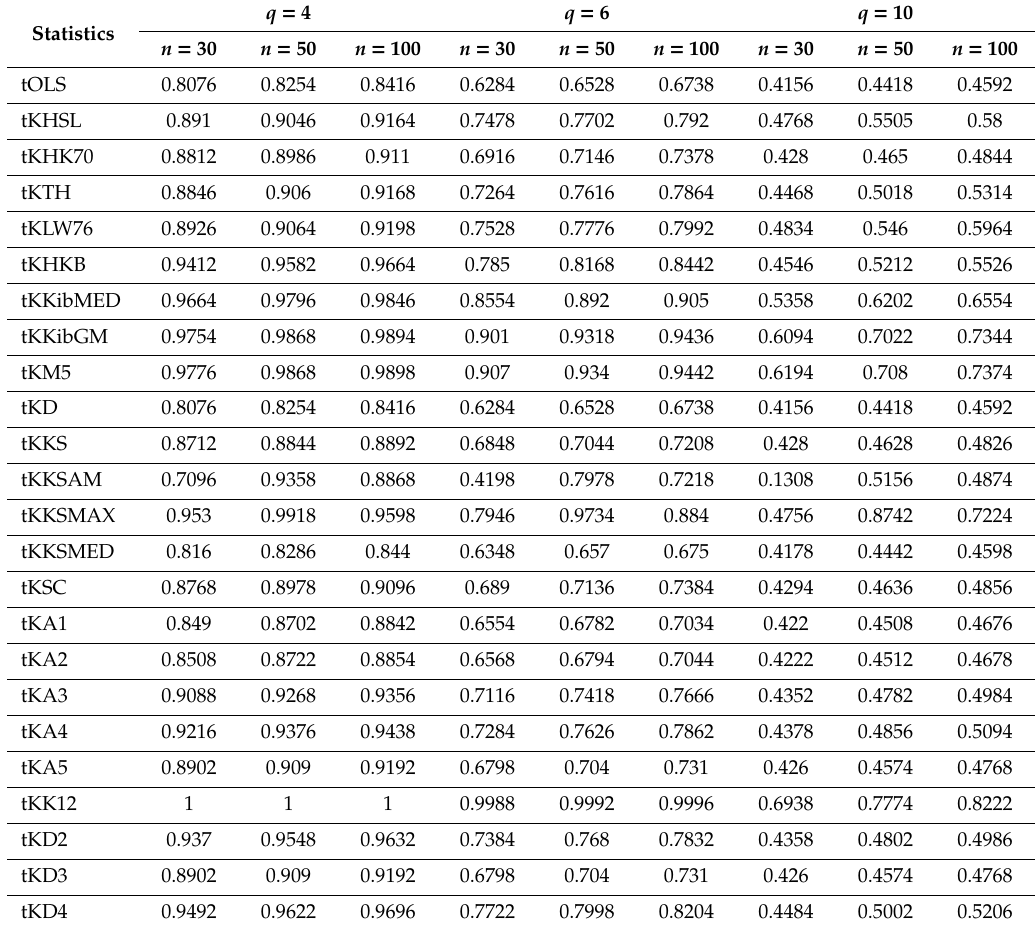
Table 6. Powers of tests for ρ = 0.95 and α = 0.05.